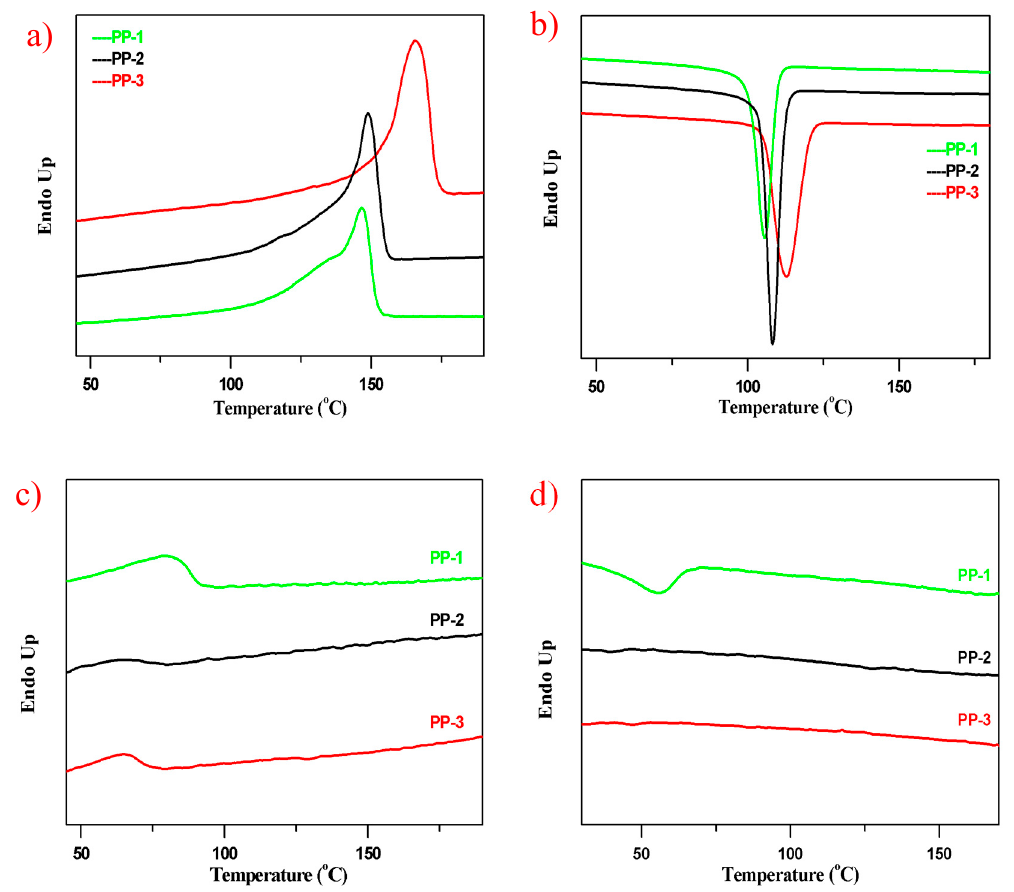
Figure 6. DSC curves of non-soluble and soluble fraction of the PP pellets from xylene at 25 ◦ C (10 ◦ C / min). ( a ) Melting curves of non-soluble fractions of the three samples; ( b ) cooling curves of non-soluble fraction; ( c ) melting curves of soluble fraction; ( d ) cooling curves of soluble fraction. Endo up: the heat flow is endothermic when the peak is up.